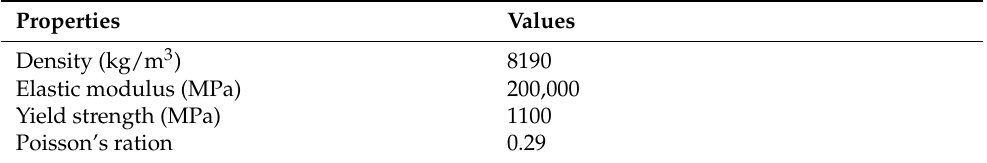
Table 2. Basic properties of the construction materials Inconel 718